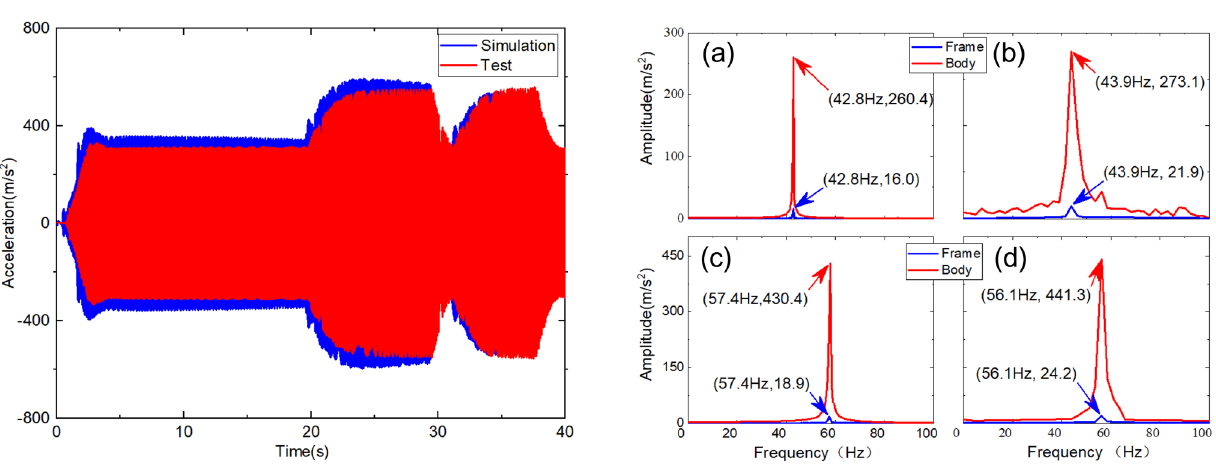
Fig. 6 Time domain data of body acceleration in vertical direction Fig. 7 FFT results of acceleration in idle